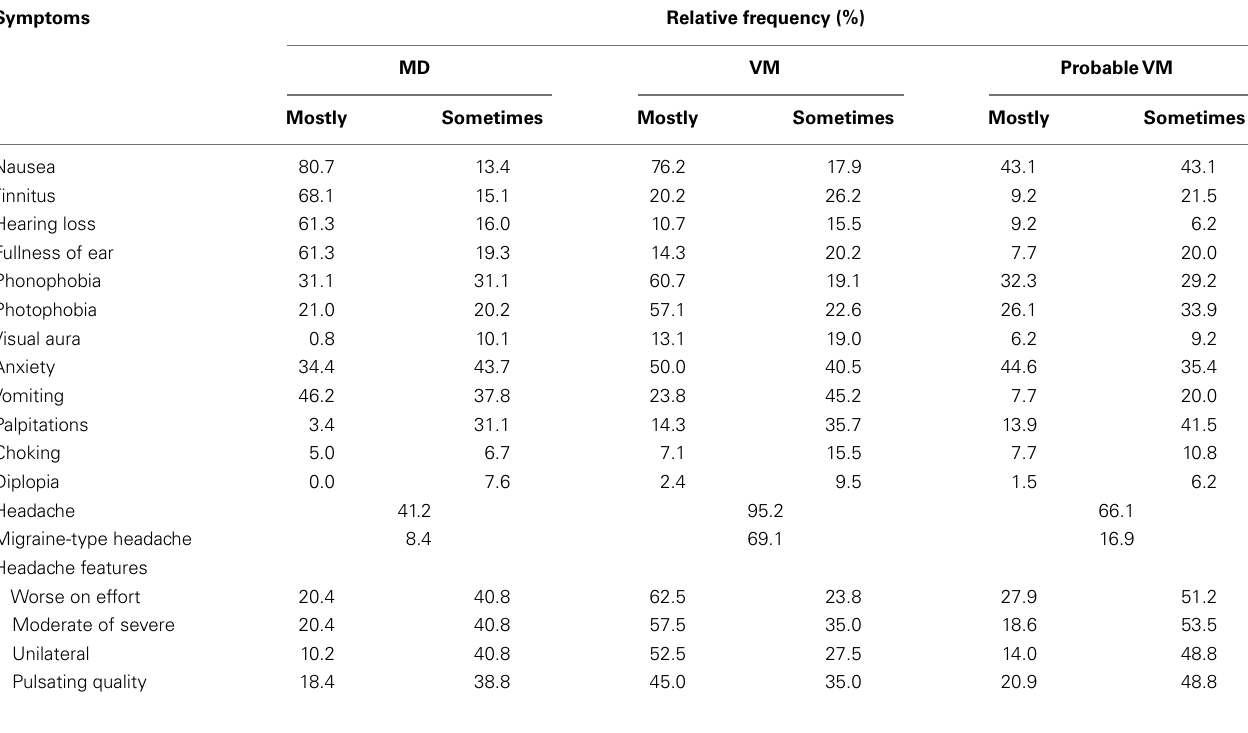
Table 2 |Accompanying symptoms reported by patients with definite and probableVM during the attack